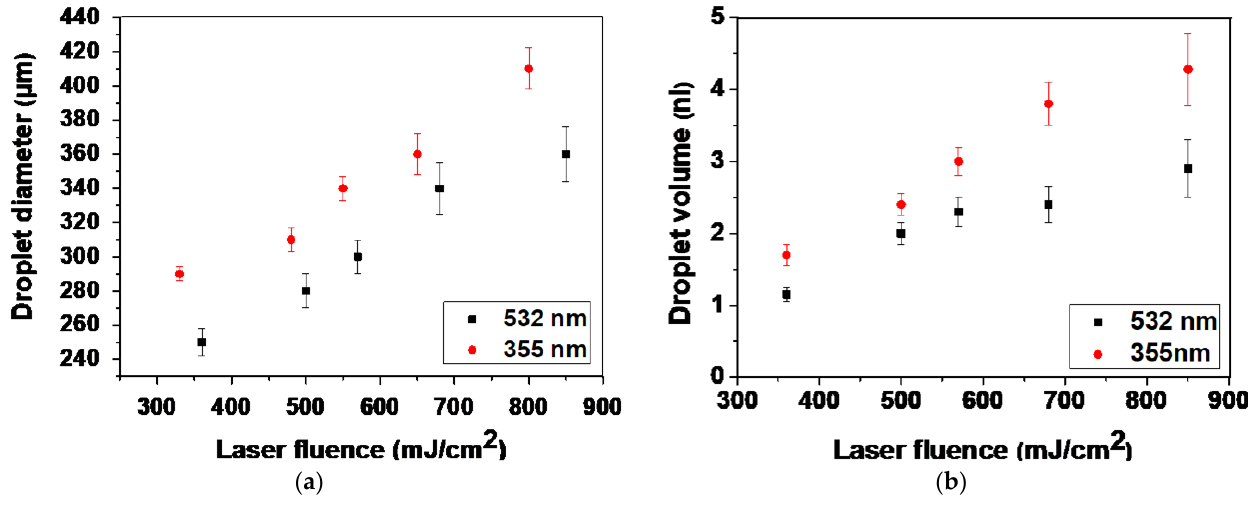
Figure 3. ( a ) LIFT-printed droplet diameter as a function of laser fluence for both wavelengths. ( b ) Droplet volume as a function of laser fluence for both wavelengths. Error bars depict SEM. n ≥ 5 droplets per condition, in at least three independent experiments.